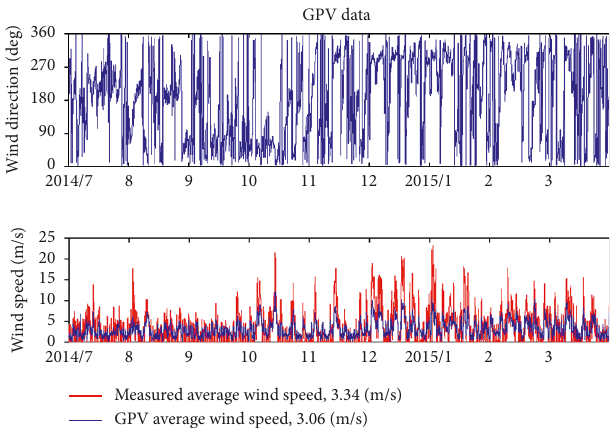
Figure 2: Comparison of measured data (5m above ground) and weather grid point value (GPV) data (10m above ground) for nine months from July 2014 to March